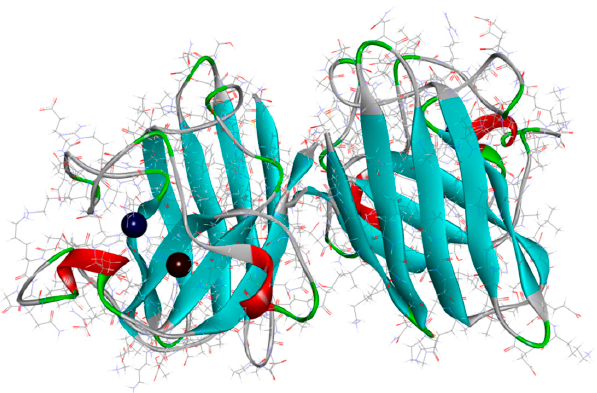
Figure 4. Human superoxide dismutase structure—SOD1 with copper (brown) and zinc (deep blue) ions (PDB code: 2C9V) [137].